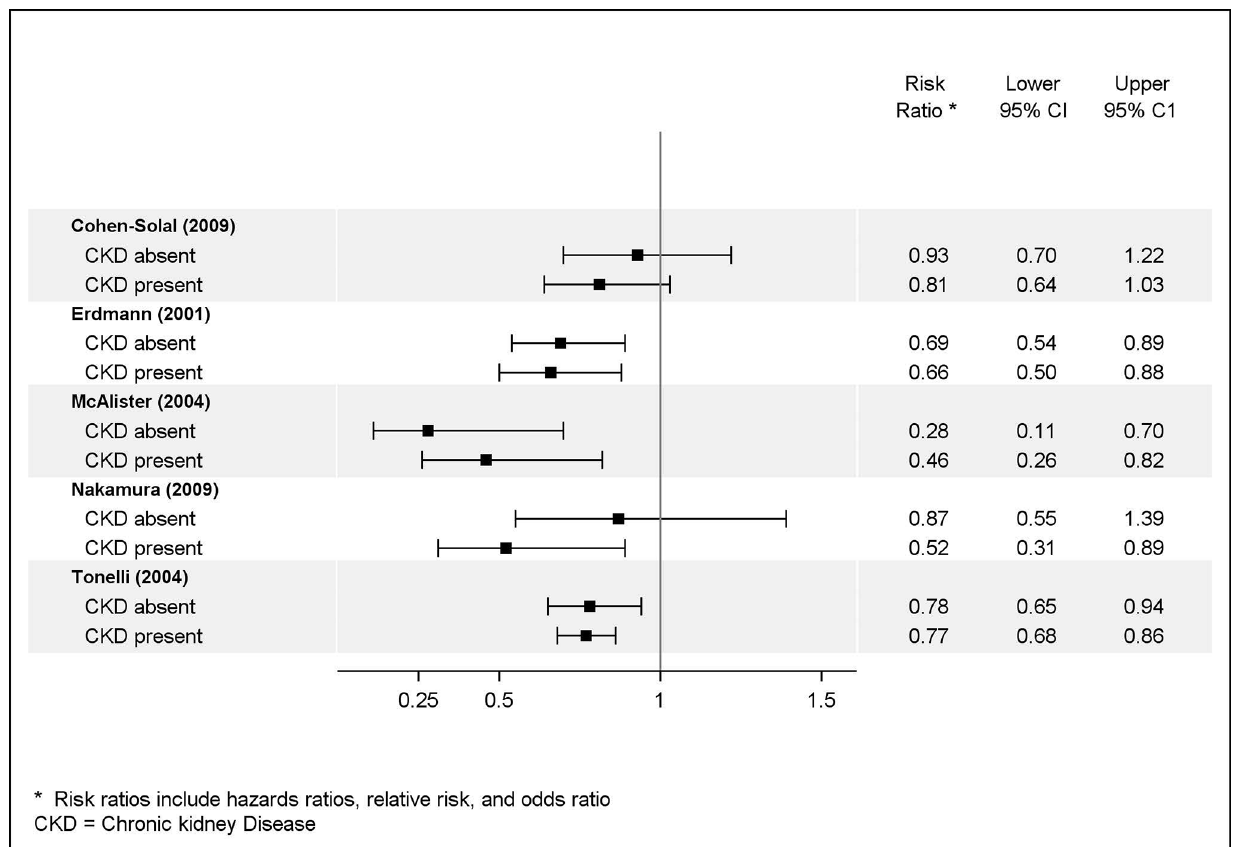
Figure 3. Risk Reduction Associated with Medication for Treatment of Cardiovascular Disease.